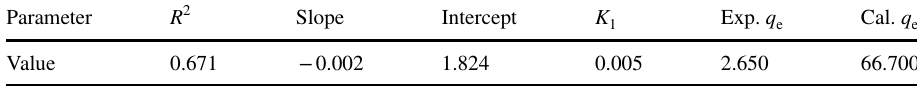
Table 7 Constants of PSO model for the adsorption process